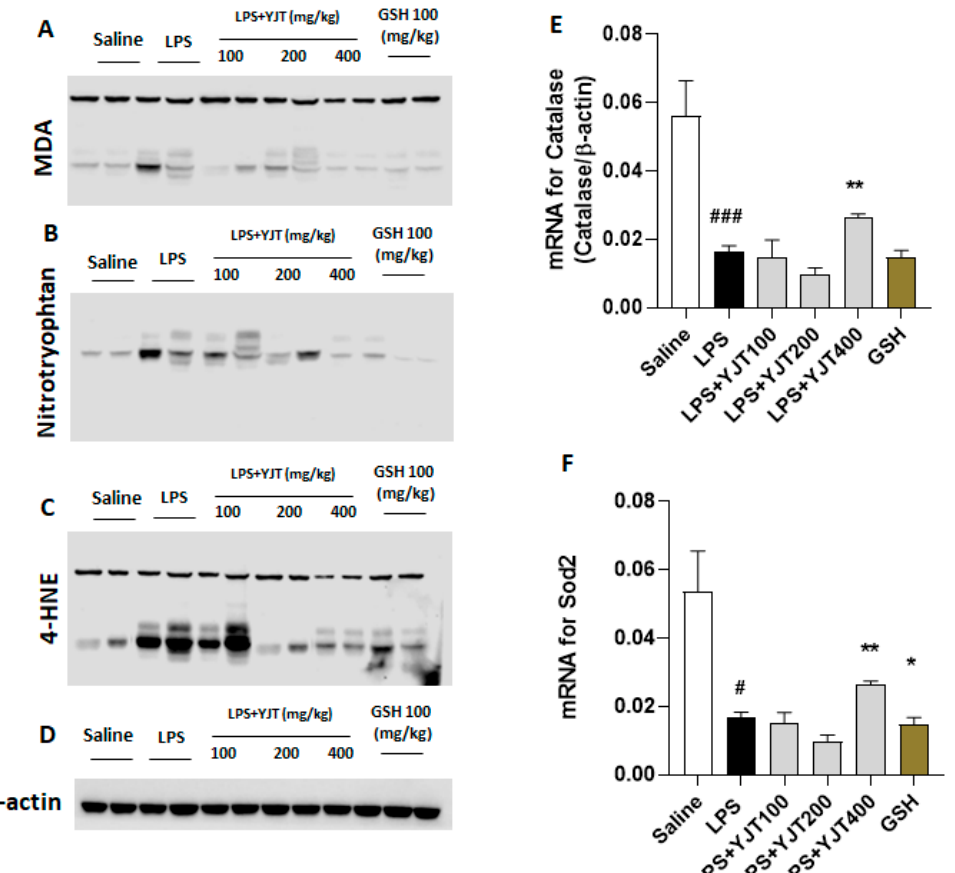
Figure 2. Western blot analysis of oxidation–related proteins and mRNA expression levels of antioxidant enzymes in hippocampus regions. Mice were sacrificed and brain tissues were removed after the final LPS injection. The hippocampus was isolated from brain tissue and prepared either protein lysates ( n = 6–9 to each group) or mRNA ( n = 4–6 to each group) samples were prepared for further analysis. Oxidative stress–related proteins including ( A ) MDA, ( B ) nitrotryptophan, and ( C ) 4–HNE were performed by Western blot analysis ( n = 4 to each group). ( D ) β –actin was used as internal control. mRNA expression levels of antioxidant enzymes such as ( E ) catalase and ( F ) Sod2 were measured ( n = 4–6 to each group). The data were expressed as mean ± SEM. # p < 0.05, and ### p < 0.001 for Con vs. LPS, * p < 0.05, and ** p < 0.01 for LPS vs. drug–administrated